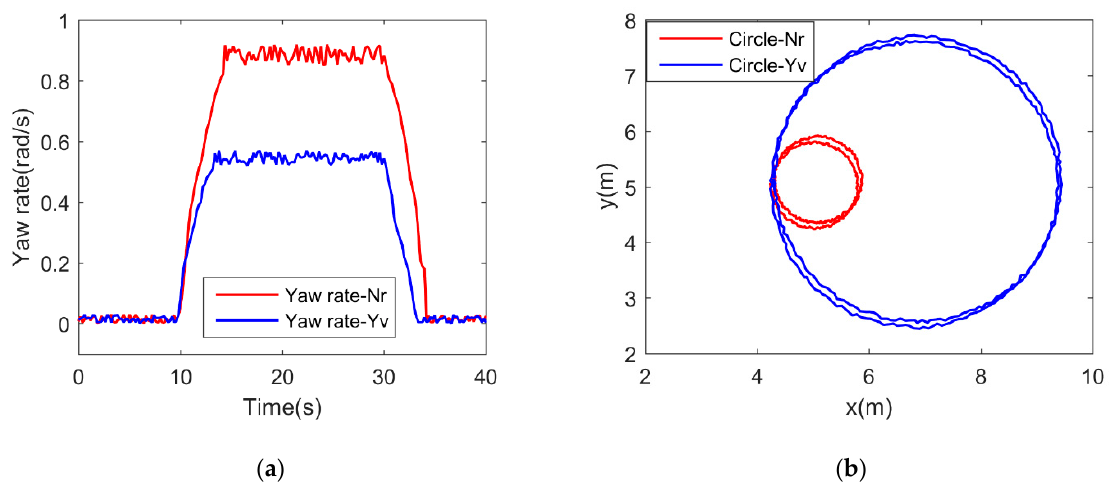
Figure 8. The experimental results of the circle test: ( a ) the yaw rates during circle tests; ( b ) the circle paths for estimating N r and Y v in circle tests.